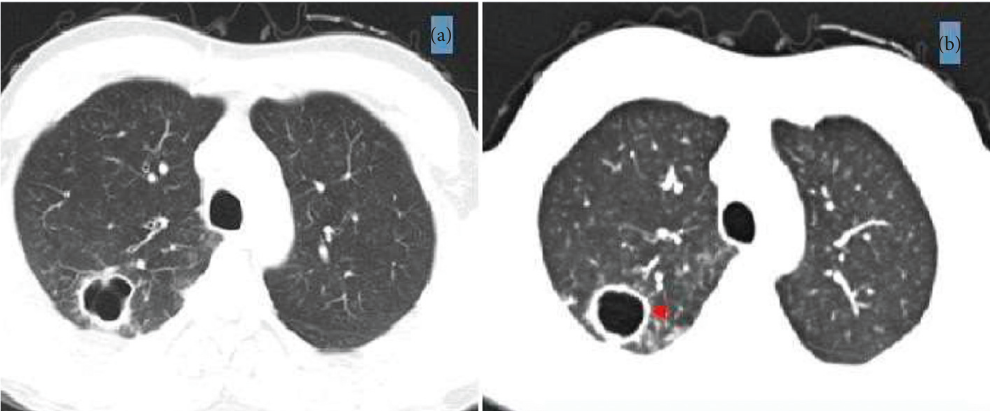
Figure 2: (a) Chest CTshowing an apical pulmonary cavity in the right lung with bronchiolitis and hilar lymphadenopathy. (b) The chest CT performed 8 months later showing a regression of the pulmonary cavity